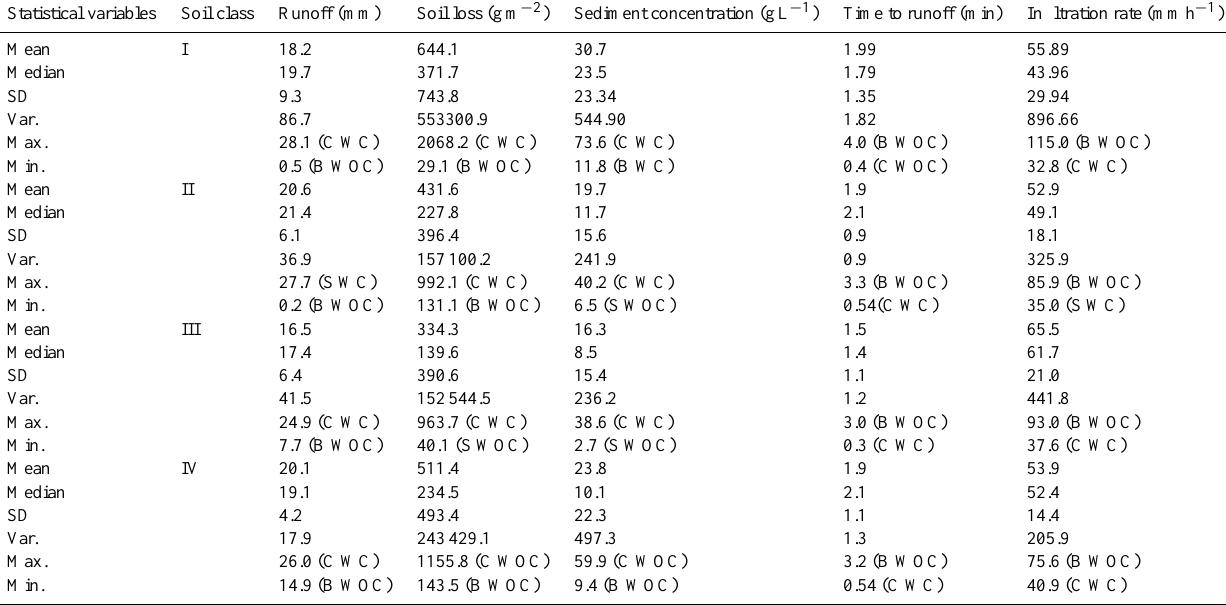
Table 4. Statistical summary of results divided in soil classes. Statistical